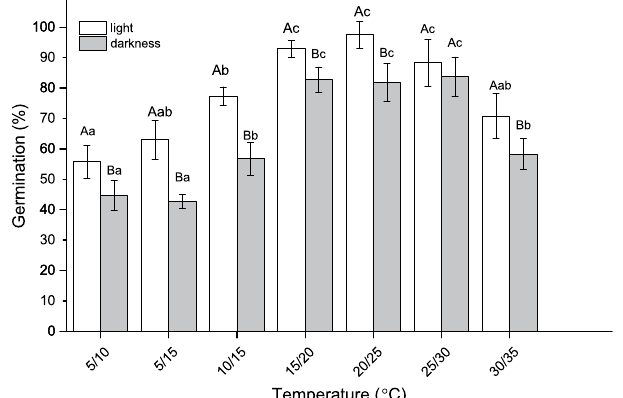
Figure 4. Germination percentage of freshly collected Astragalus adsurgens seeds at different temperatures in light and darkness. Error bars represent the standard deviation. Different upper-case letters indicate significant difference between groups under light and darkness. Different lower-case letters denote significant differences within group at different temperatures.